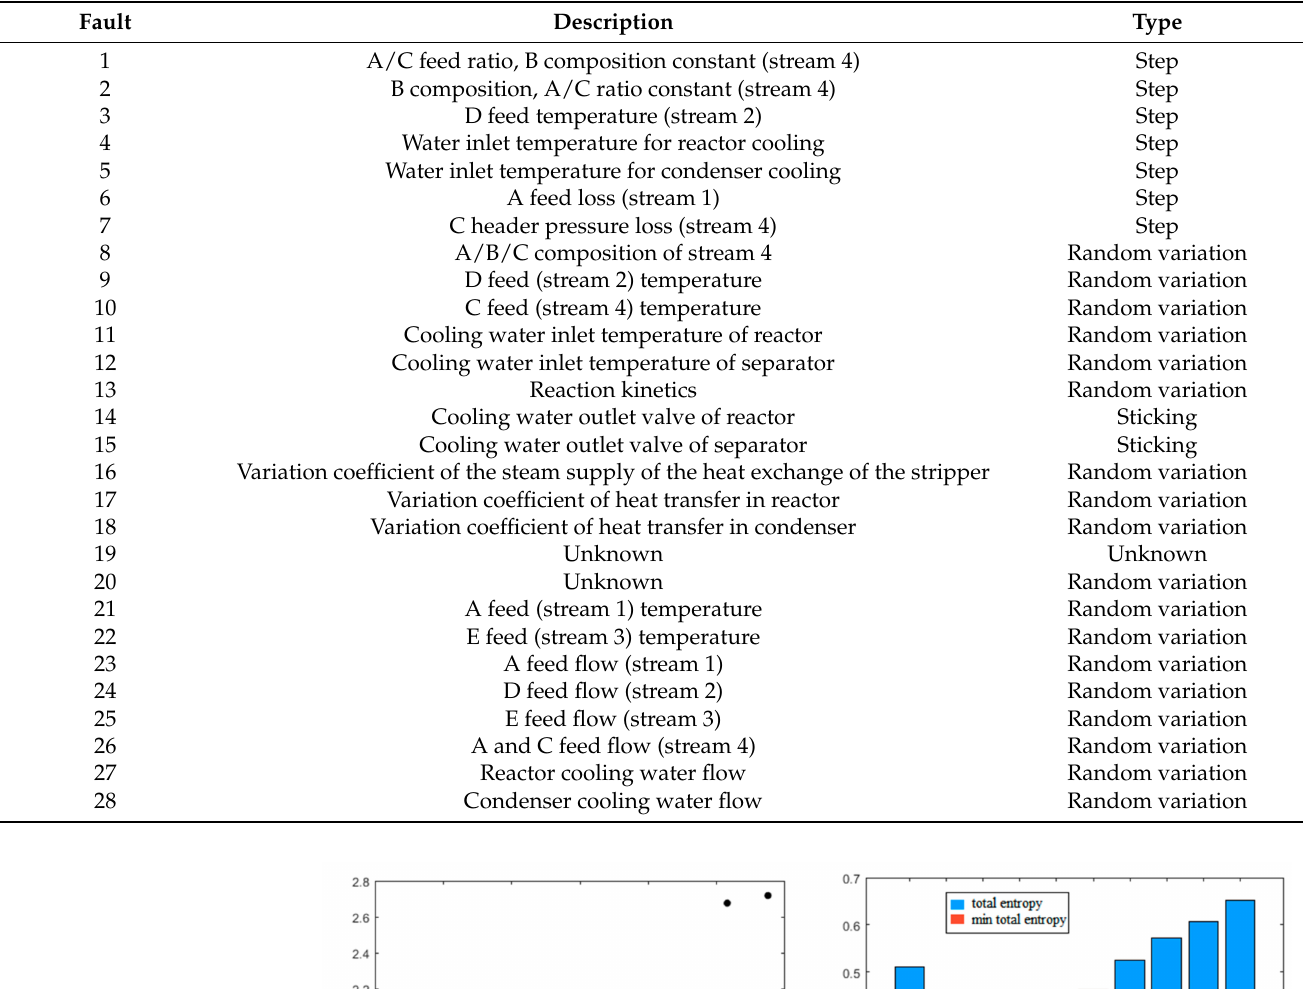
Table 1. Description of faults in the TE process.